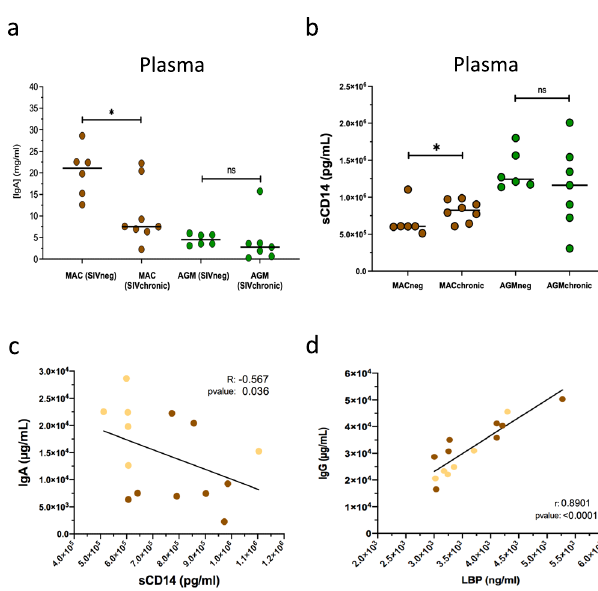
Fig. 3 IgA titers negatively correlated with sCD14 in peripheral blood during SIVmac infections. a IgA titers in plasma from MAC and AGM (non- infected (SIVneg) and chronically SIV-infected (SIVchronic)) ( n = 6-8 animals). A nonparametric Mann – Whitney test ( p ≤ 0.05 = *; p ≤ 0.01 = **; p ≤ 0.001 = ***) was used. b Plasma titers of sCD14 from non-infected (SIVneg) and chronically SIV-infected (SIVchronic) MAC and AGM ( n = 6 non-infected animals per species, n = 8 chronic MAC and n = 7 chronic AGM). From Figure A to C, a nonparametric Mann – Whitney test ( p ≤ 0.05 = *; p ≤ 0.01 = **; p ≤ 0.001 = ***) was used. Each dot represents an individual animal. c Correlation between microbial translocation marker sCD14 in plasma and plasmatic-IgA in MAC (non-infected animals in light brown and chronically infected animals in dark brown) ( n = 6 – 8 animals). d Correlation between in fl ammatory (LBP) and plasmatic-IgG in MAC (non-infected animals in light brown and chronically infected animals in dark brown) ( n = 6 – 8 animals). Spearman r test was used ( p ≤ 0.05 = *; p ≤ 0.01 = **; p ≤ 0.001 = ***). Each dot represents an individual